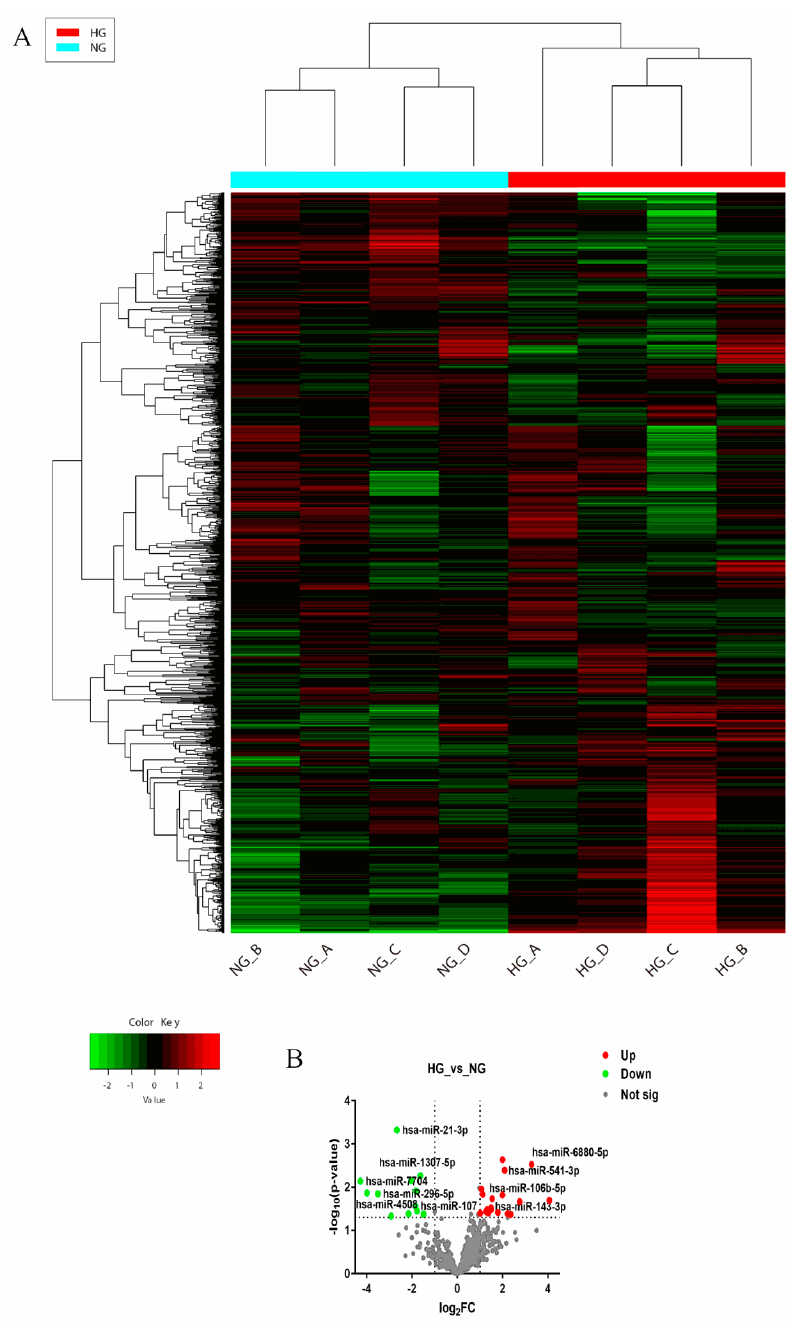
Figure 3. MiRNA sequencing. Eight samples were divided into four groups with one sample of NG and HG in each group. These samples were sequenced and subjected to bioinformatic analysis. ( A ) The heatmap indicates closeness between these groups. Red color reveals high expression of miRNAs, and green color reveals low expression of miRNAs. ( B ) The volcano plot showed the up- and down-regulated miRNAs in HG vs. NG. Red dots demonstrate the upregulated miRNAs, and green dots reveal downregulated miRNAs. The thresholds are defined as follows: upregulated miRNAs (Log 2 FC > 1, FC > 2, p < 0.05), downregulated miRNAs (Log 2 FC < − 1, FC < 1/2, p < 0.05). HG—high glucose; NG—normal glucose; Not sig—not